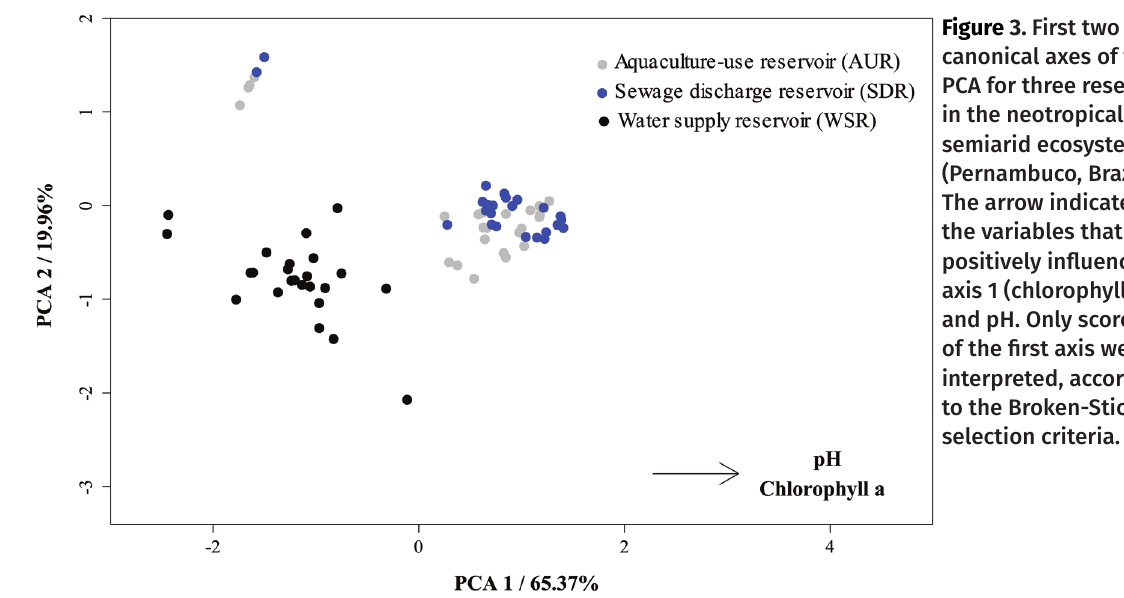
Figure 3. First two canonical axes of the PCA for three reservoirs in the neotropical semiarid ecosystem (Pernambuco, Brazil). The arrow indicates the variables that most positively influenced axis 1 (chlorophyll a and pH. Only scores of the first axis were interpreted, according to the Broken-Stick selection